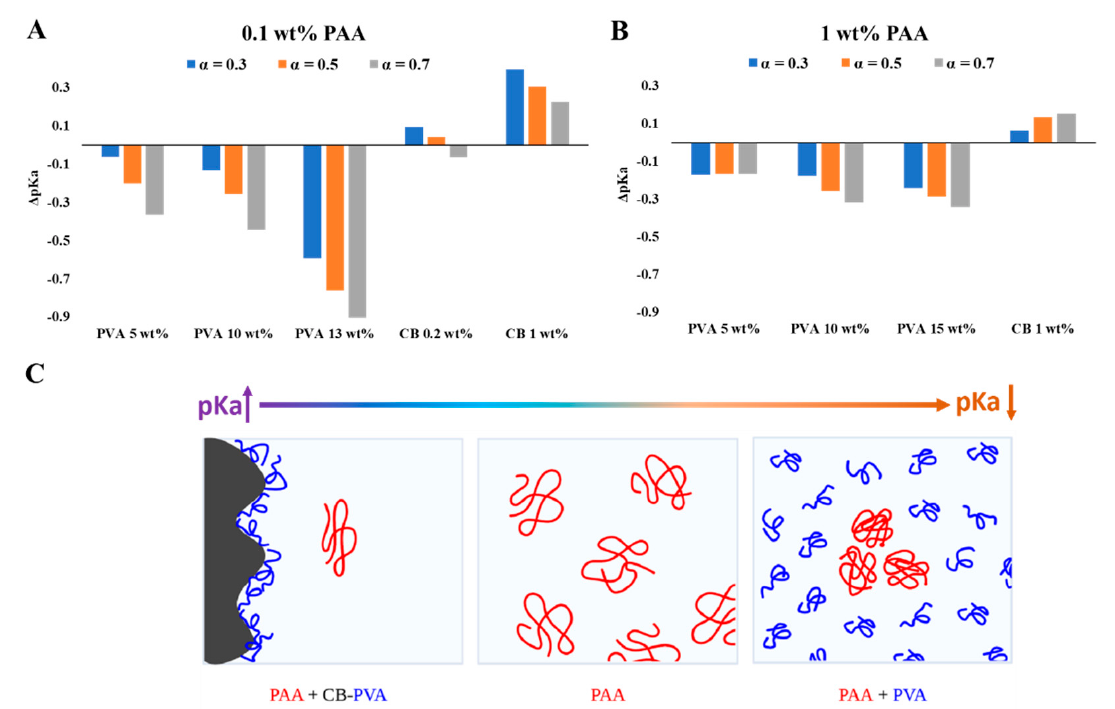
Figure 7. The pK a shift (compared to DIW) of PAA 100 kDa 0.1 wt% ( A ) and 1 wt% ( B ) at different ionization degrees. ( C ) Schematic illustration of the mixtures.